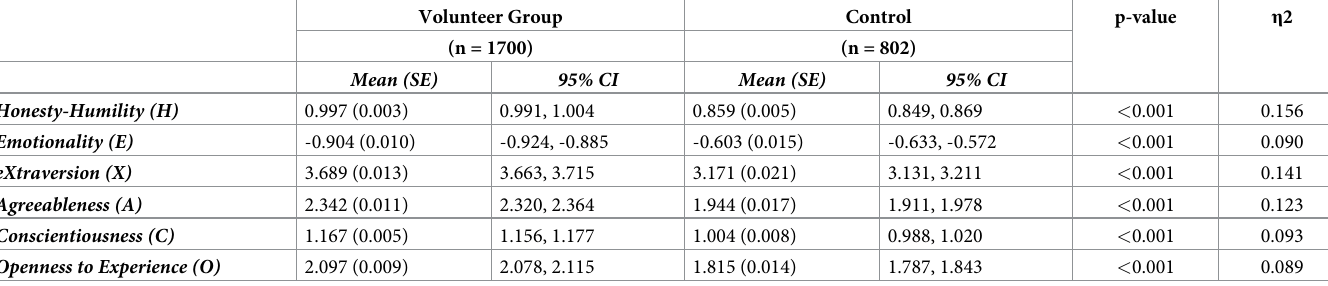
Table 3. Comparisons of HEXACO fitted scores by volunteer vs. control group